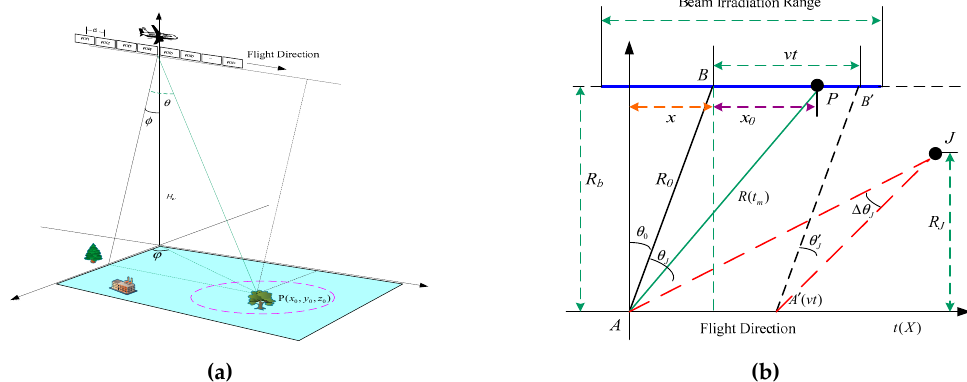
Figure 1. Diagram of the multi-channel SAR. ( a ) 3D geometry model; ( b ) Geometry relationship in the slant plane.